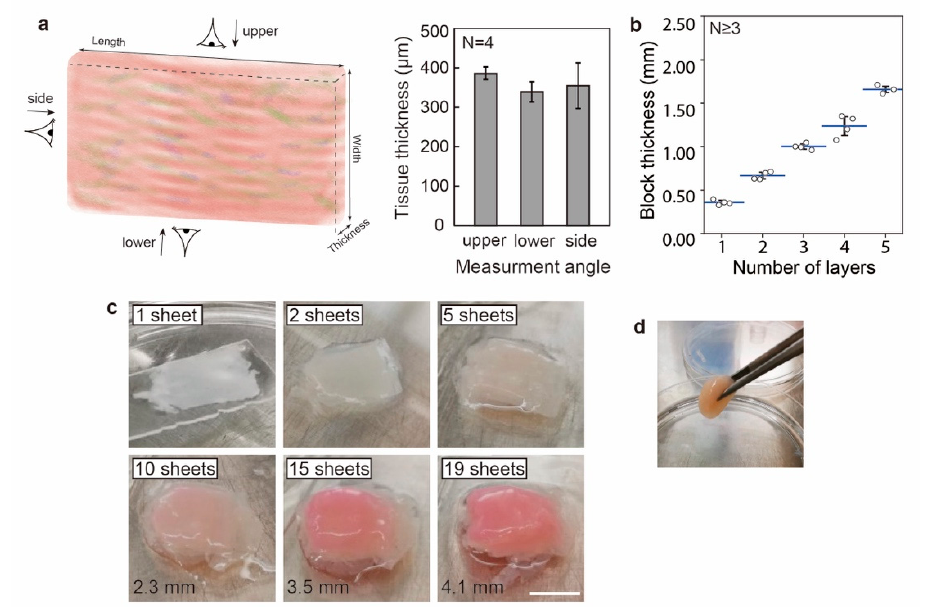
Figure 4. Assembly of subcentimeter-order tissue block by stacking the plane-shaped skeletal muscle tissues. ( a ) Thickness of a single piece of muscle tissue measured in various regions. ( b ) The thickness of the assembled tissue after stacking with various layers of plane-shaped skeletal muscle tissue. ( c ) Photo images of the assembled tissues. ( d ) Photo image of the assembled tissue manipulated by a tweezer. Scale bars: 1